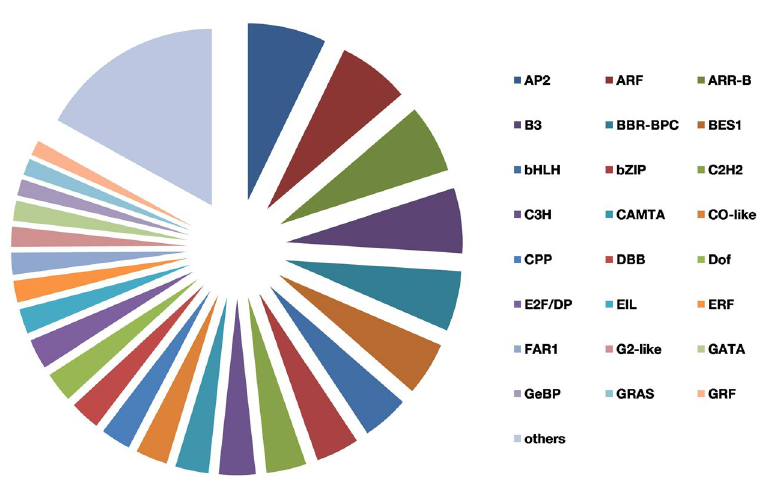
Figure 8. Transcription factors identified from Solanum trilobatum leaf transcriptome.